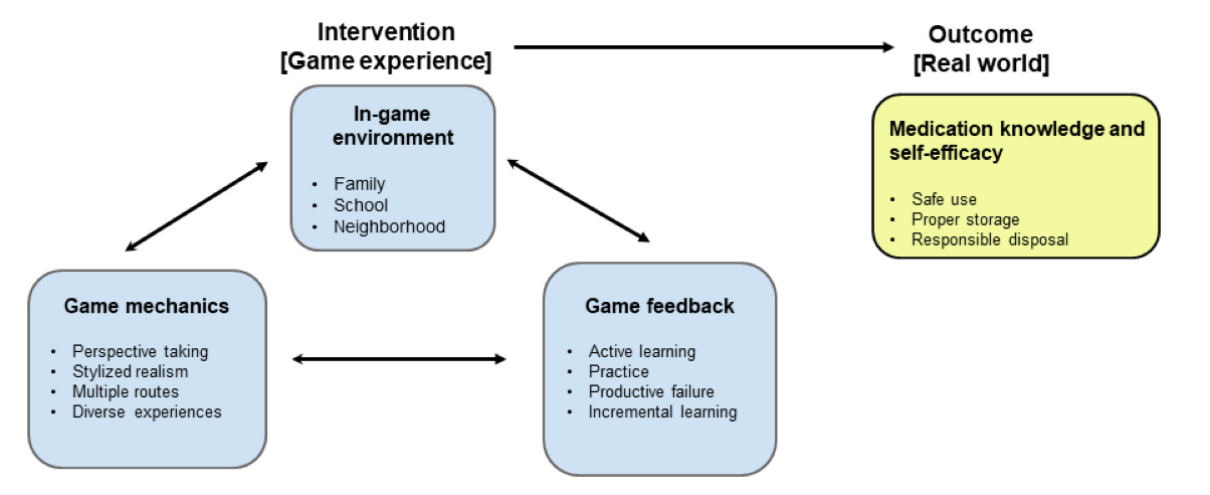
Figure 1. Serious game framework for improving medication safety in community